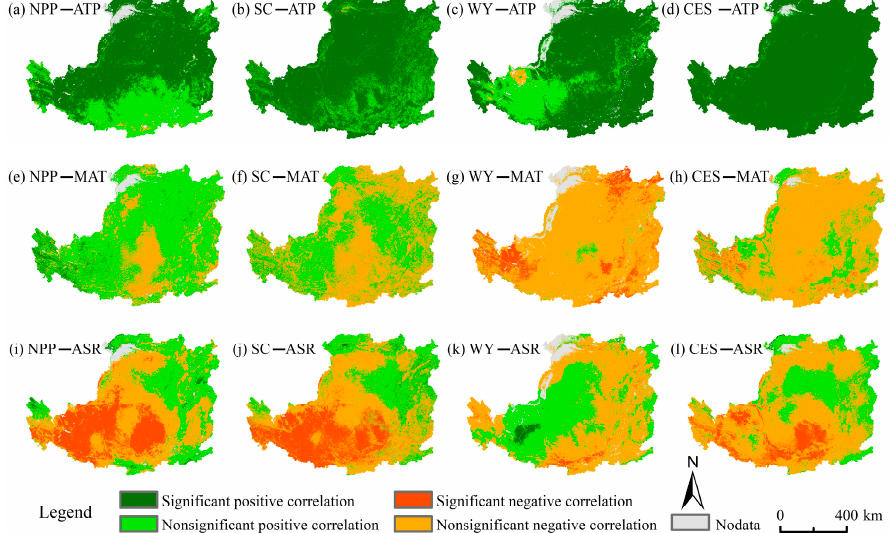
Figure 5. Correlation among the ESs and the climate factors (Note: ( a – d ) are the spatial relationships among ESs and ATP; ( e – h ) are the spatial relationships among ESs and MAT; ( i – l ) are the spatial relationships among ESs and ASR).